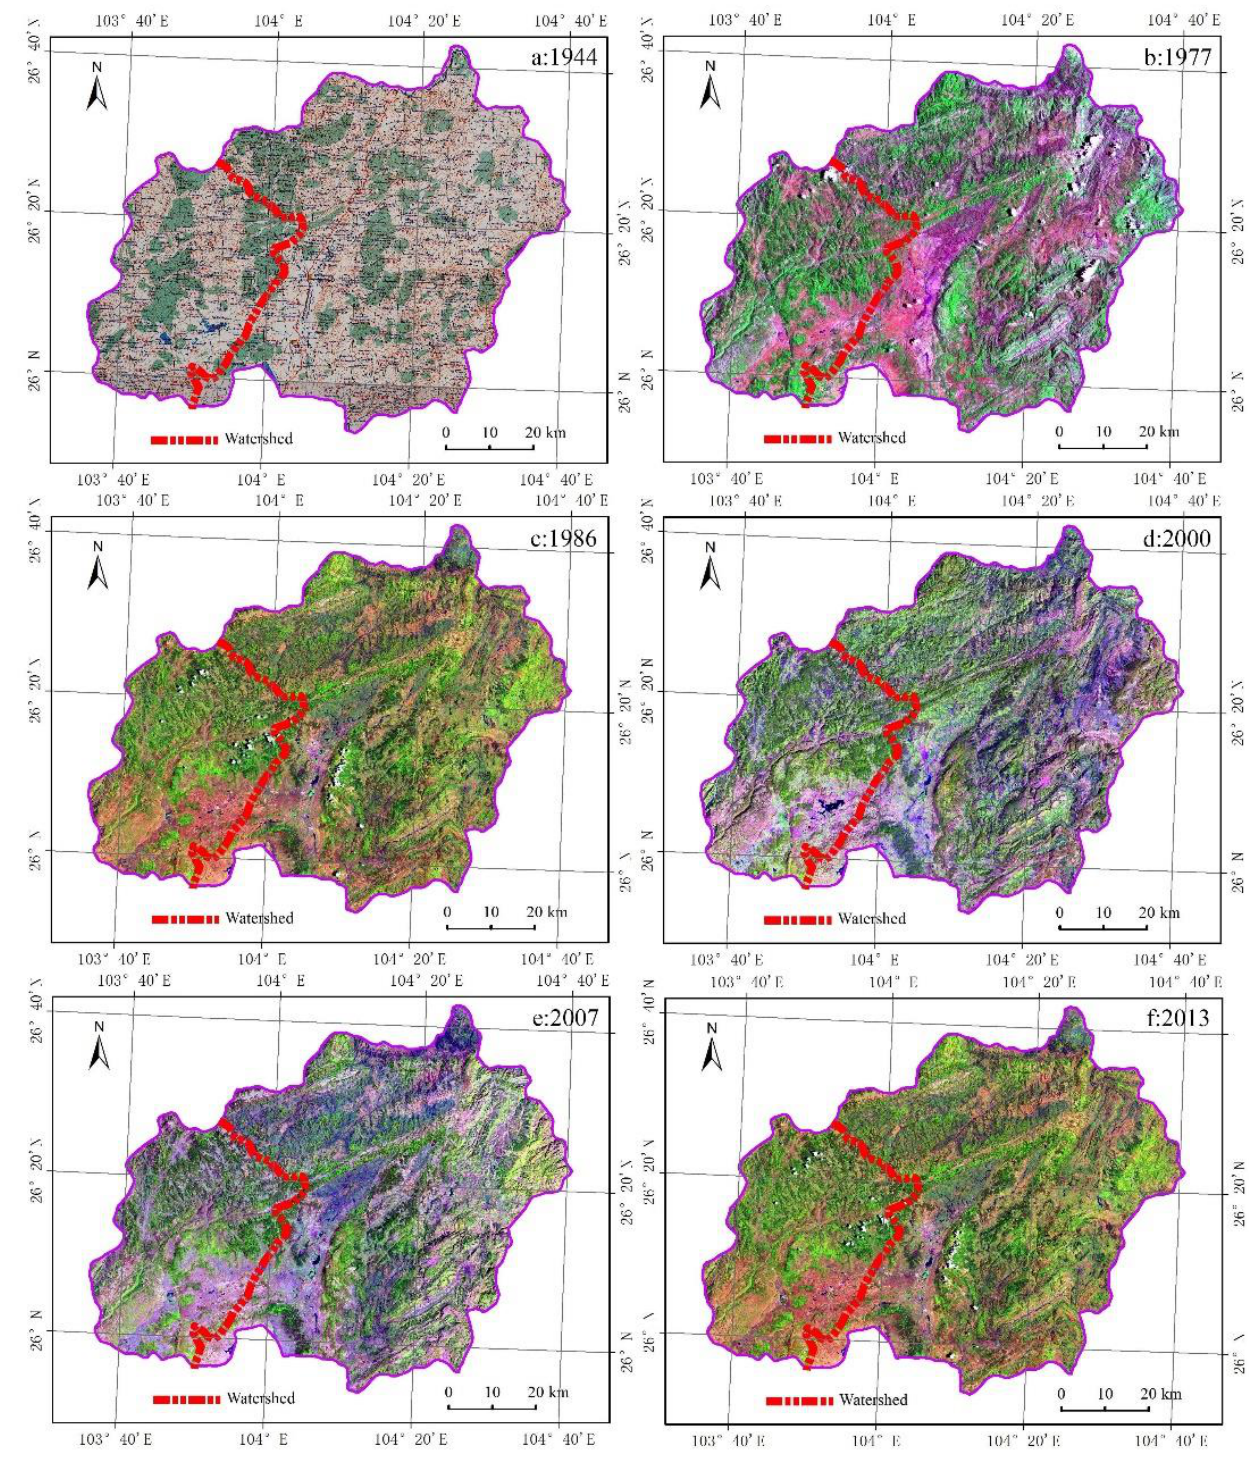
Figure 3. The military map and remote sensing images in different times. (We constructed this map using ArcGIS9.3 (http://www.esri.com/arcgis/about-arcgis) (accessed on 19 December 2021))